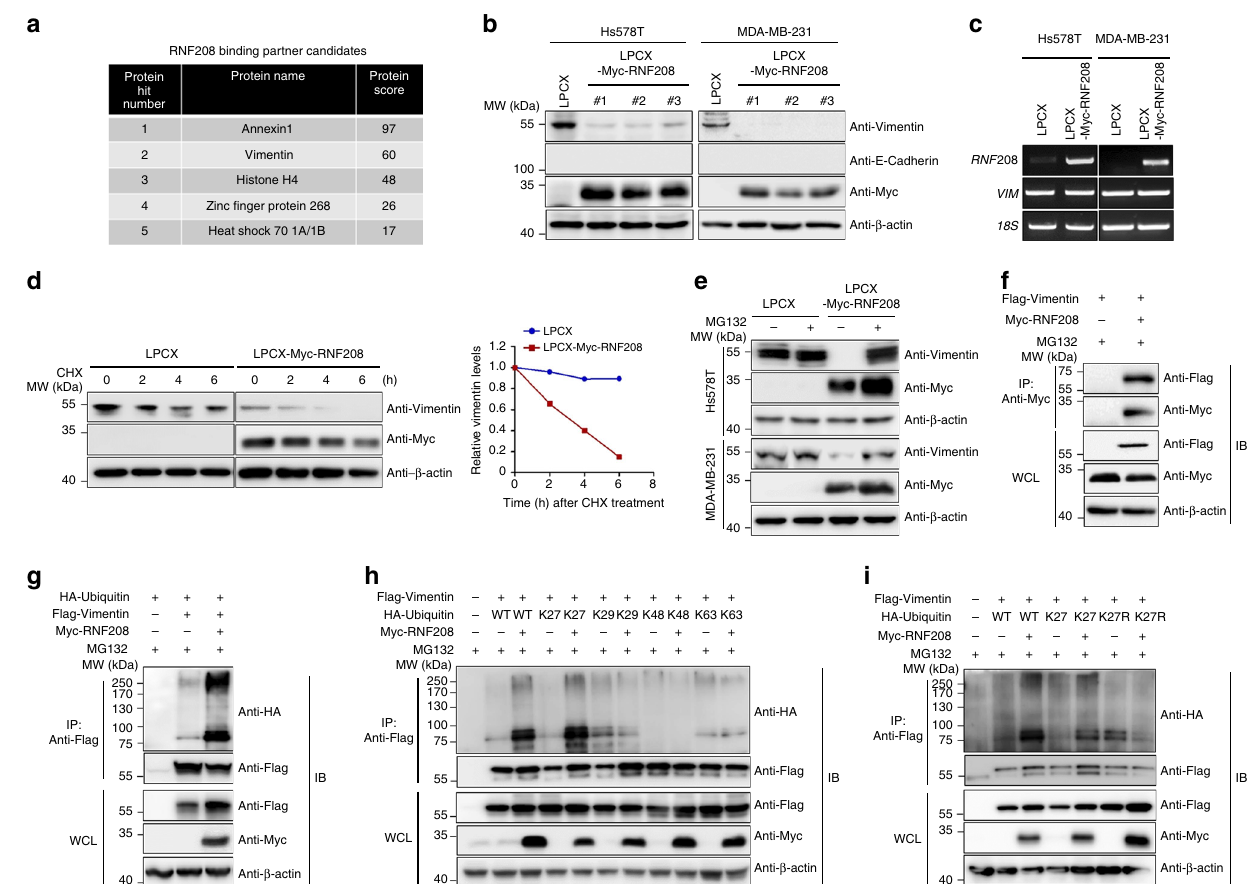
Fig. 4 RNF208 induces the proteasomal degradation of Vimentin protein by facilitating K27-linked polyubiquitination. a List of RNF208 binding partner candidates analyzed from the mass spectrometry-based crosslinking assay. b Immunoblot analysis showing Vimentin, E-cadherin, and RNF208 in control and RNF208-overexpressing Hs578T and MDA-MB-231 clonal cells (#1 − #3). β -actin was used as an internal control. c RT-PCR showing RNF208 and VIM expression in control and RNF208-overexpressing Hs578T or MDA-MB-231 cells; 18S was used as an internal control. d Immunoblot analysis showing the stability of the Vimentin protein in control and RNF208-overexpressing MDA-MB-231 cells in the presence of cycloheximide (CHX, 50 μ g ml − 1 ) for the indicated times (left). The data were quanti fi ed using ImageJ software (right), and β -actin expression was used for normalization. e Immunoblot analysis showing the expression level of Vimentin protein in control and RNF208-overexpressing Hs578T and MDA-MB-231 cells with the proteasome inhibitor MG132. Cells were treated with 10 μ M MG132 for 6 h, and cell lysates were subjected to immunoblotting with the indicated antibodies. f Immunoprecipitation assay showing the endogenous interaction between RNF208 and Vimentin. Cells were cotransfected with Myc-RNF208 and Flag- Vimentin plasmids in 293T cells upon MG132 treatment. Cell lysates were immunoprecipitated with anti-Myc antibody and then immunoblotted with the indicated antibodies. WCL whole-cell lysates. g Immunoprecipitation assay showing the ubiquitination of Vimentin by ectopic expression of RNF208. 293T cells were cotransfected with HA-Ubiquitin, Flag-Vimentin, or Myc-RNF208 plasmids in 293T cells upon MG132 treatment. Vimentin ubiquitination was detected by immunoprecipitation with anti-Flag and then immunoblotted with the indicated antibodies. h Immunoprecipitation assay showing K27- mediated ubiquitination of Vimentin by RNF208. The 293T cells were cotransfected with Flag-Vimentin, different linkages of HA-Ubiquitin (wild-type, K27, K29, K49. K63), or Myc-RNF208 plasmids, and then, cell lysates were immunoprecipitated with anti-Flag antibody. i Flag-Vimentin plasmid was cotransfected into 293T cells together with wild-type, K27 or lysine mutant (K27R) of HA-Ubiquitin in the absence or presence of Myc-RNF208 plasmid. Cells lysates were immunoprecipitated with anti-Flag antibody and then immunoblotted with the indicated antibodies. Unprocessed original scans of blots in ( b − i ) are shown in Supplementary Fig.